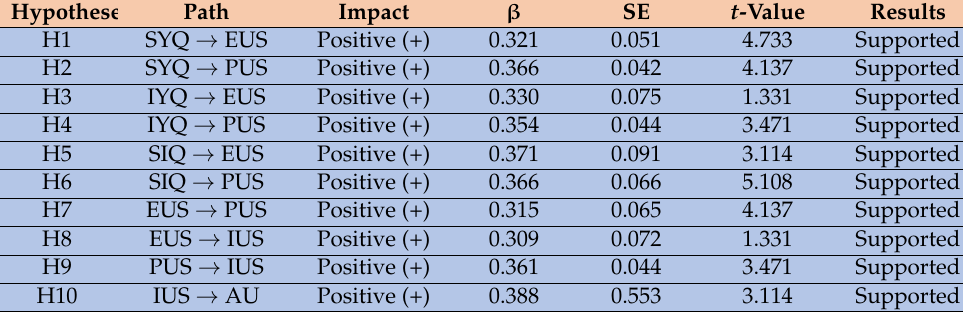
Table 16. Results of the structural equation modeling